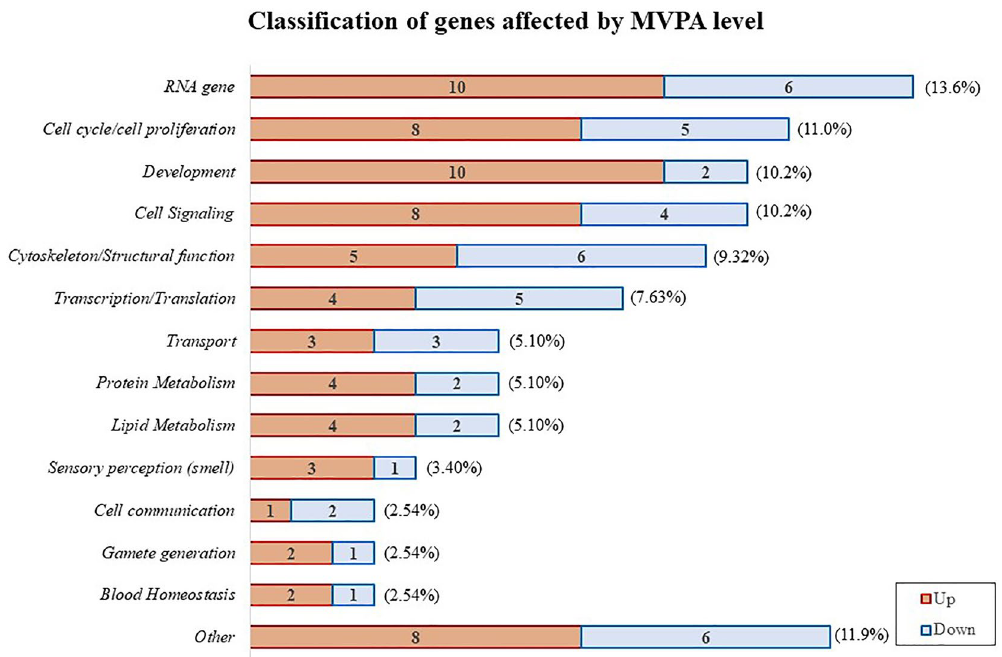
Figure 4. Classification of the 118 known genes differently expressed (p < 0.01) depending on children’s MVPA levels (low or high), into biological processes according to their main biological function. The numbers of up- (red) or down- (blue) regulated genes in children with lower physical activity versus those with higher activity are also indicated. The percentage of genes in each biological function vs. total differentially expressed are shown in parentheses.